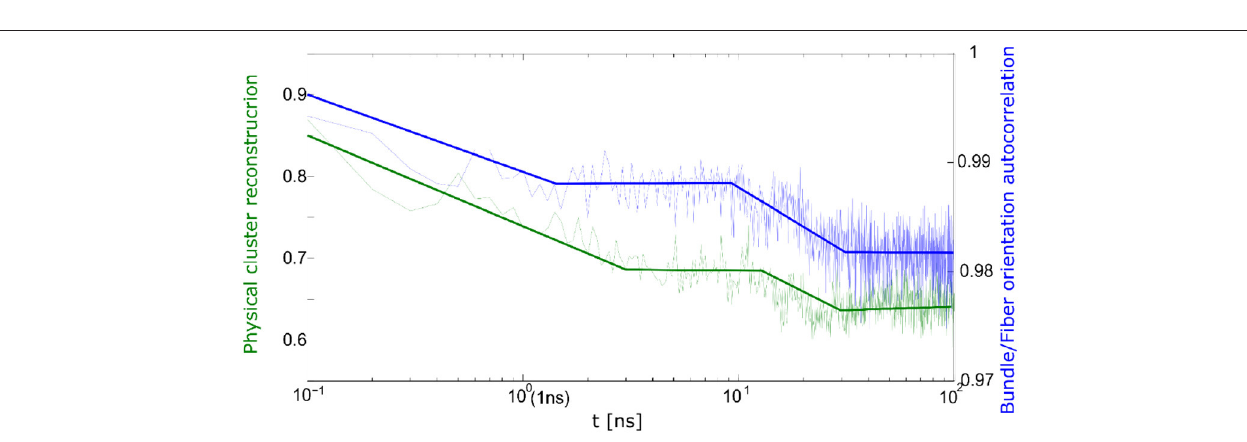
FIGURE 11 | Correlation between bundle orientation (blue) and cluster reconstruction (green) during relaxation